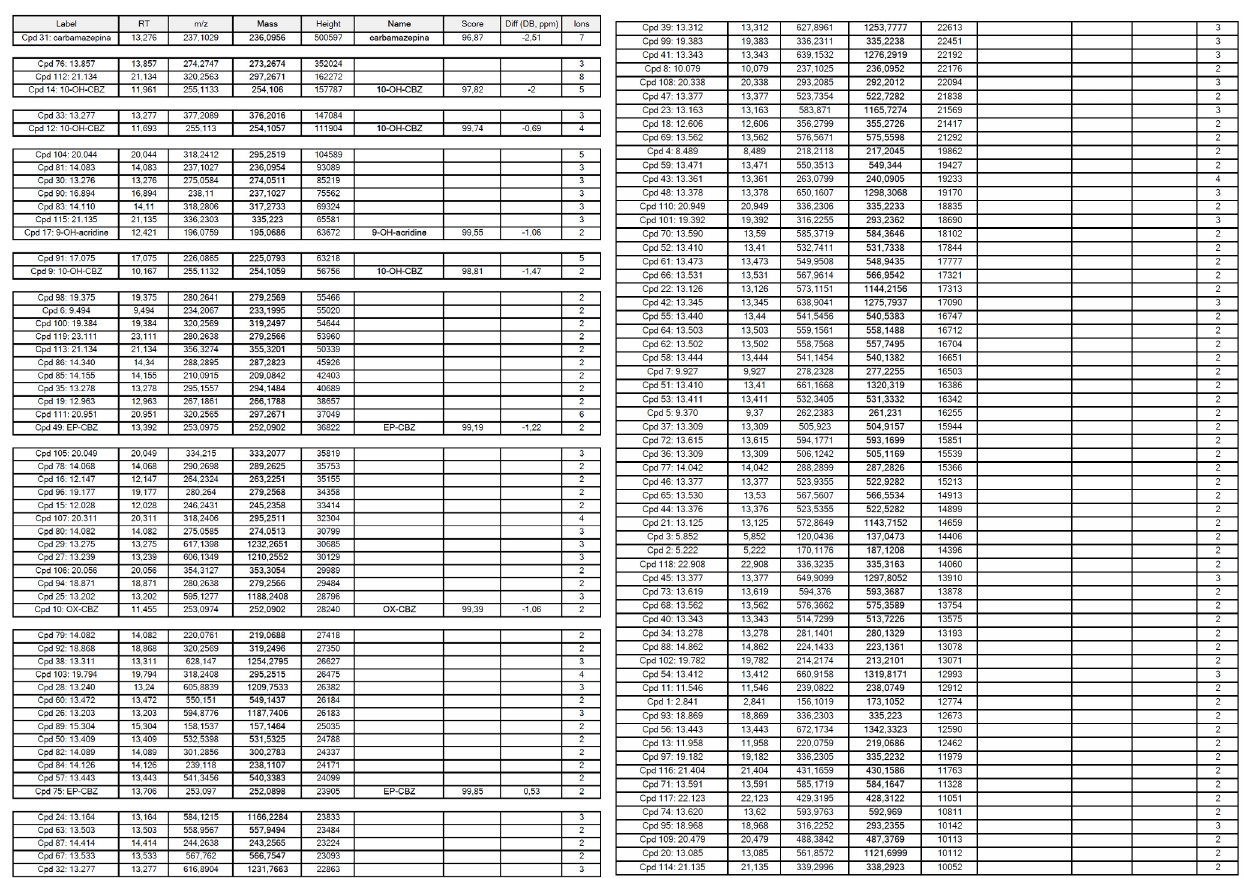
Figure A1. Major ions (m/z) and experimental masses calculated for each of the intermediate compounds detected in a sample of carbamazepine oxidized by photo-Fenton treatment under operating conditions that lead to the formation of coloured solution.